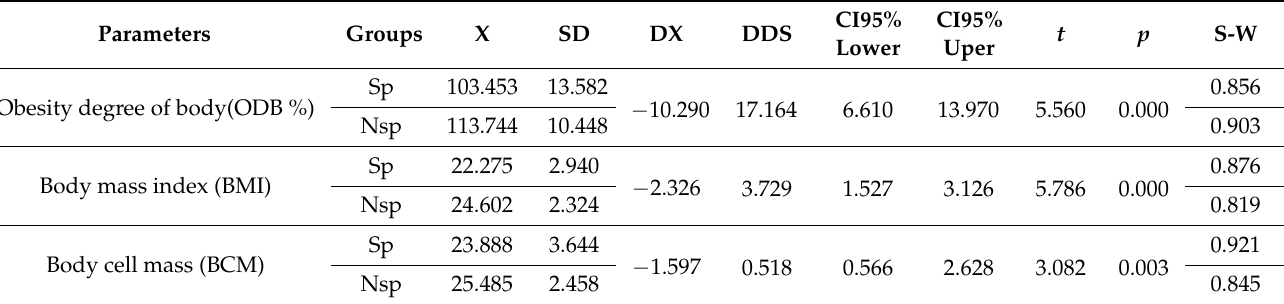
Table 3. Statistical analysis of the body composition parameters in male